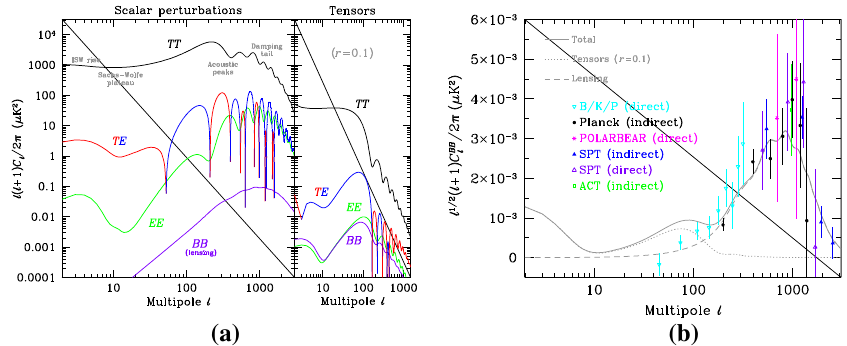
Fig. 83 Panel a shows the theoretical predictions for the temperature and polarization cross-spectra from scalar and tensor perturbations for the best fit Λ CDM model from Planck , assuming a tensor-to-scalar ratio of r = 0 . 1. The curves are labeled by type: TT labels the temperature power spectrum, while T E labels the temperature- E -modecrossspectrumandsoon.Panel b comparesrecentmeasurementsofthe BB spectrum to the theoretical prediction. Images reproduced with permission from Olive et al. (2014), copyright by UC